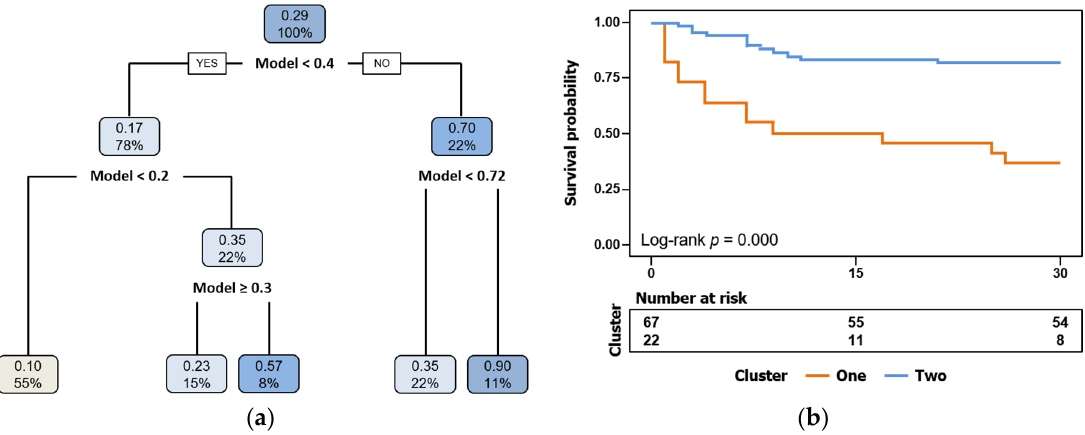
Figure 4. Survival analysis based on regression model. ( a ) Risk mortality tree generated by classification and regression tree (CART) analysis; ( b ) Kaplan–Meier curve for overall survival based on CART analysis.